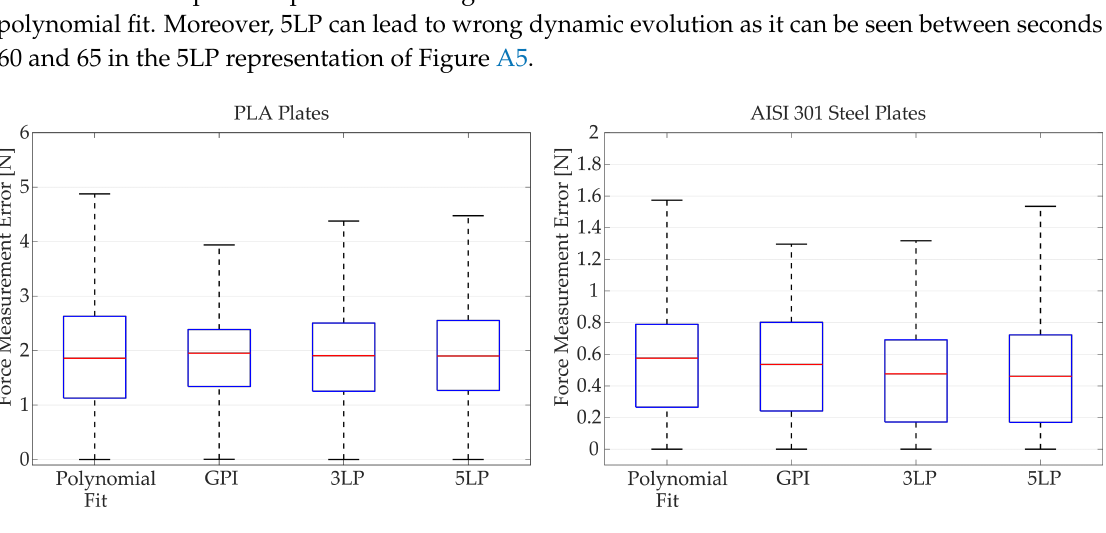
Figure 11. Error distribution of each fitting model evaluated over all the test signals. The red line indicates the mean value, blue boxes enclose the samples between percentiles 25 and 75, and black whiskers covers an standard deviation of ± 2.7 SD